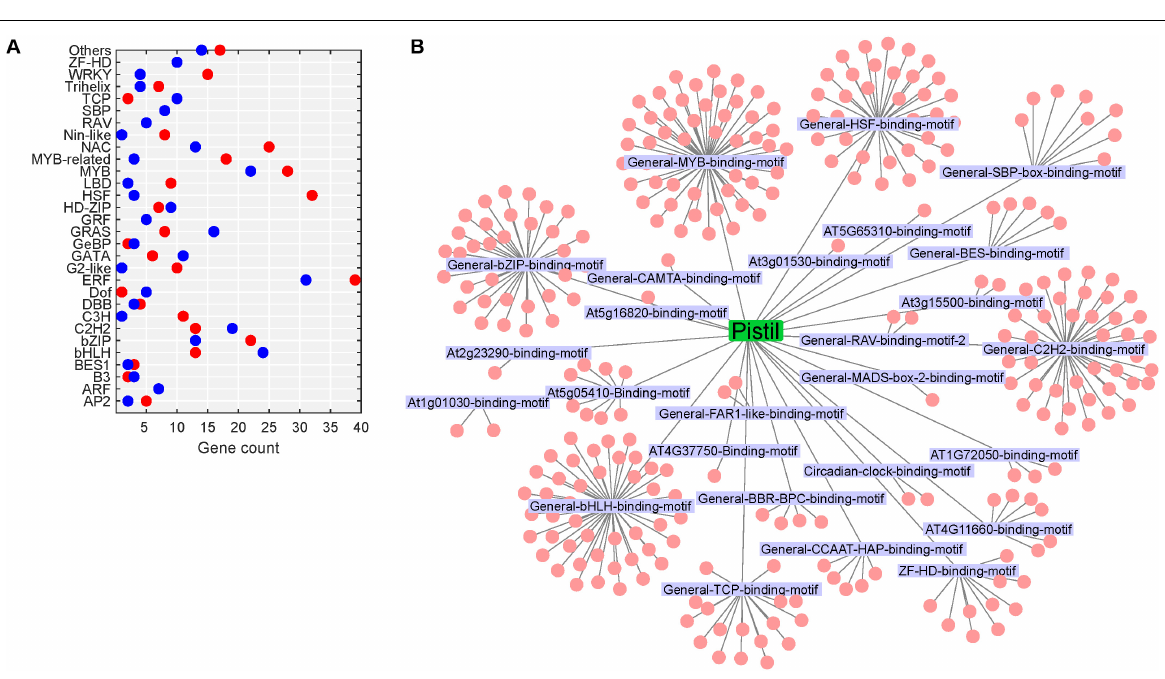
including TFs and their binding sites active in heat stress response in pollen and pistil ( Figures 9B , 10B